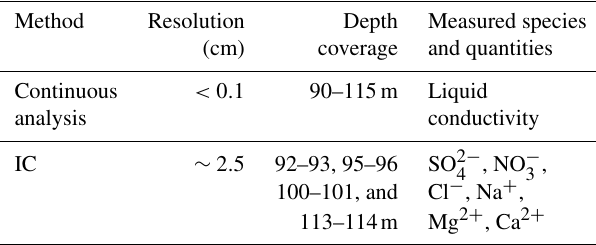
Table 1. Summary of chemistry and impurity measurements, with associated species and typical